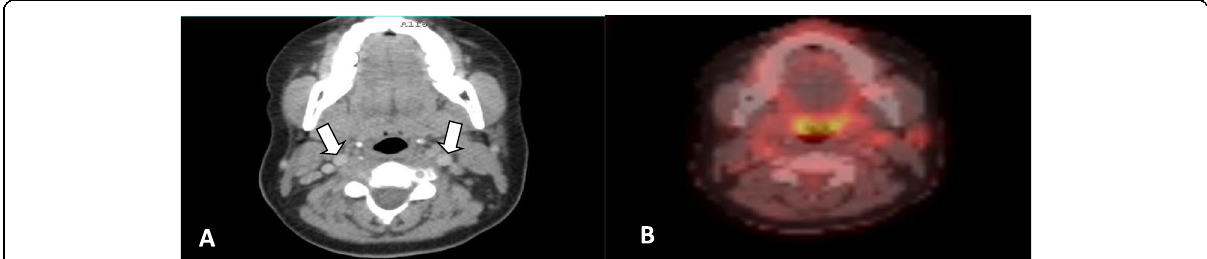
Fig. 6 Twenty-year-old patient, known case of treated Hodgkin lymphoma, finished chemotherapy. Few bilateral deep cervical LNs ( a and b ) of low grade metabolic activity are noted reaching up to 2.5 SUV max, mostly reactive in nature, consistent with a score of 1 on the five-point